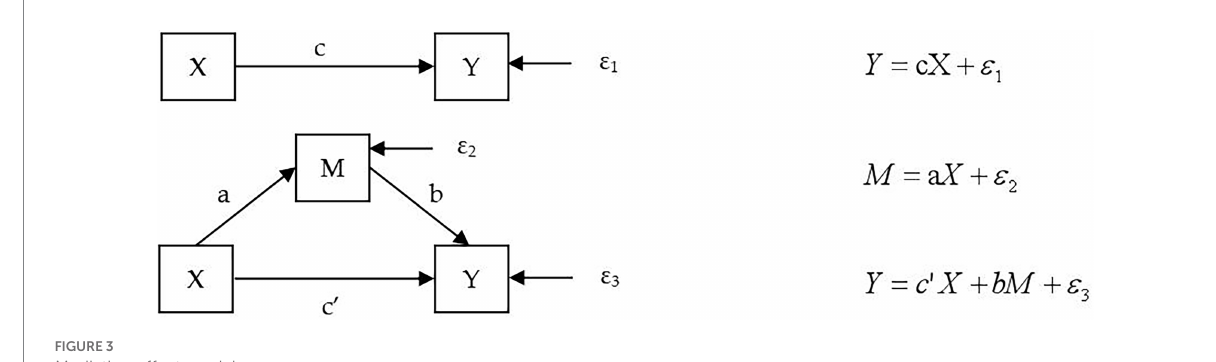
FIGURE 3 Mediating effect